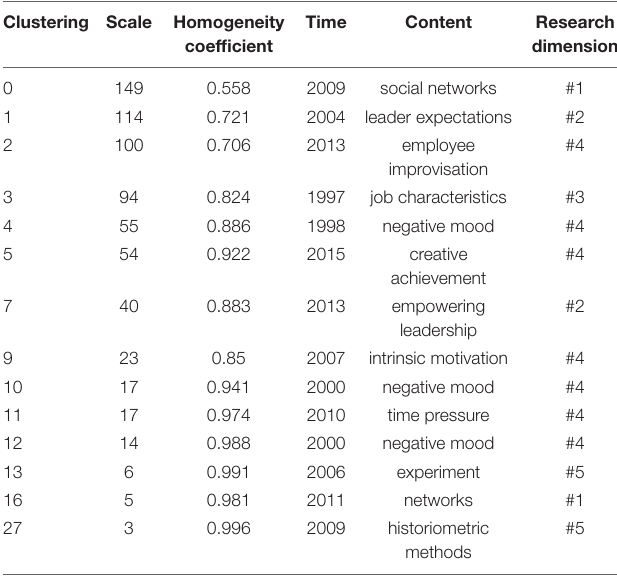
TABLE 1 | Research contents based on co-citation literature